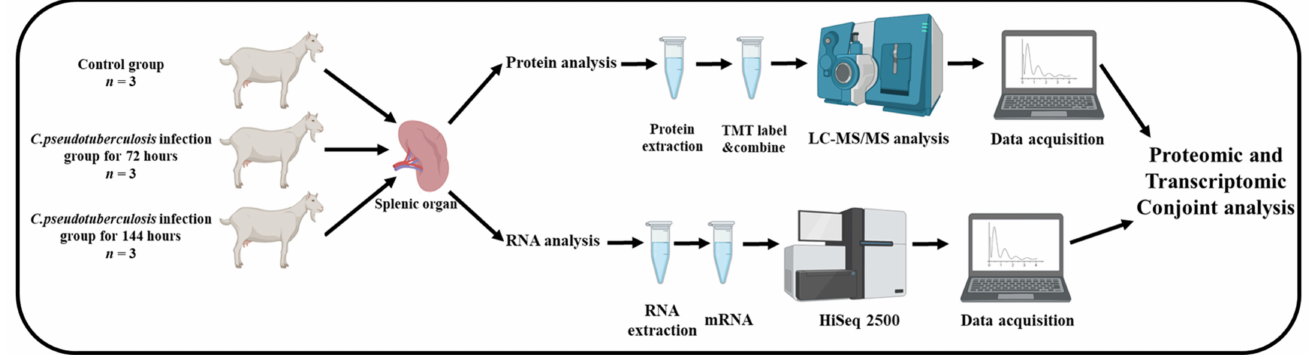
Figure 1. Experimental design and workflow of RNA sequencing and proteomic comparison of dairy